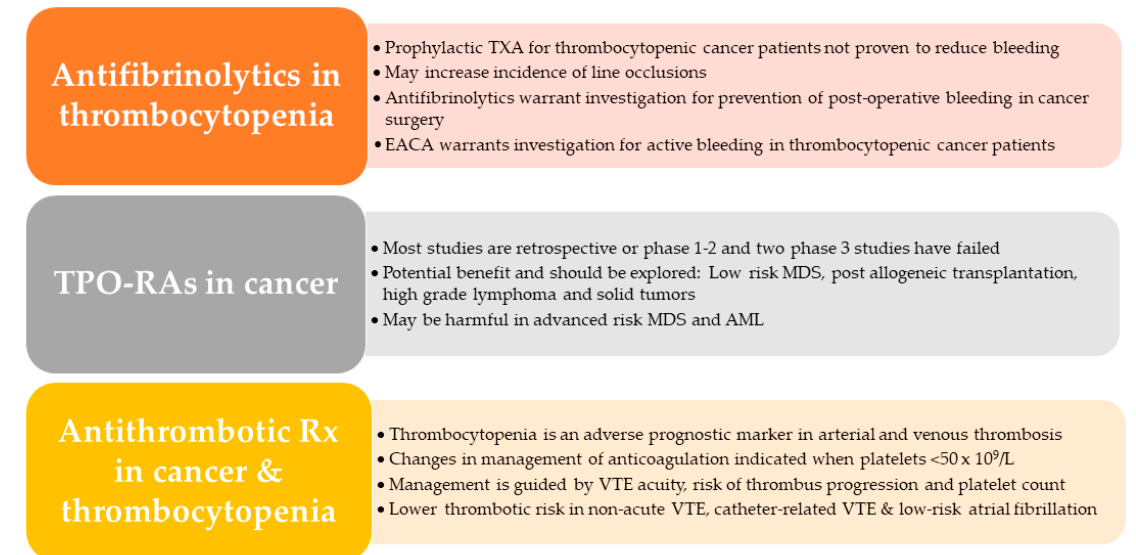
Figure 2. Take-home messages. AML , acute myeloid leukemia; EACA, epsilon aminocaproic acid; MDS , myelodysplastic syndrome; TPO-RA , thrombopoietin receptor agonists; TXA , tranexamic acid; VTE , venous thromboembolism.